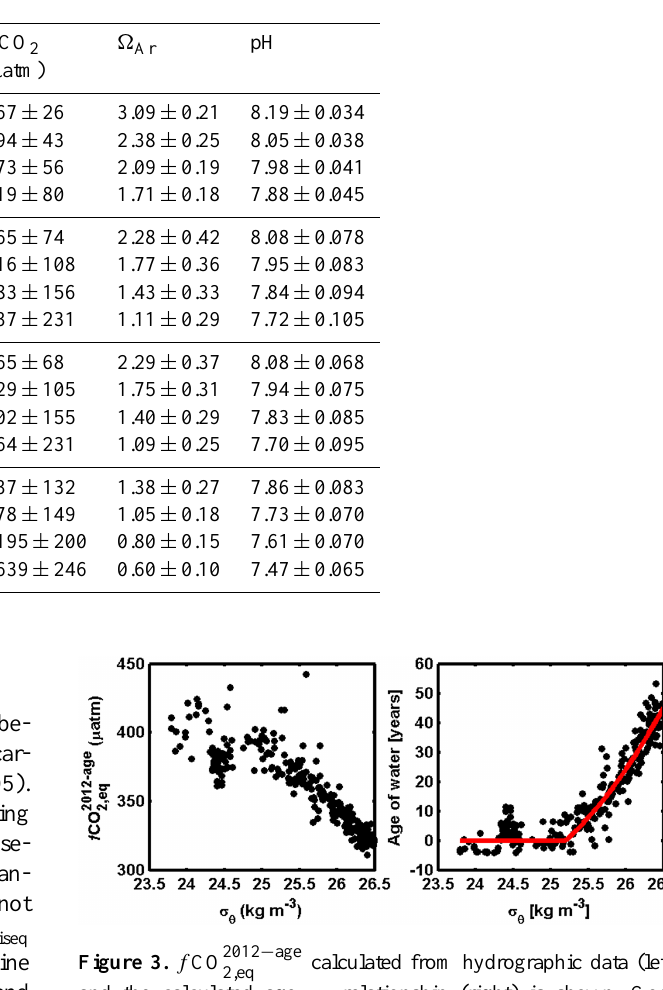
Table 2. Mean ± SD of modeled carbonate parameters at in situ conditions for preindustrial, 2012, 2060, and 2100 using the RCP6.0 projec- tion at each habitat.